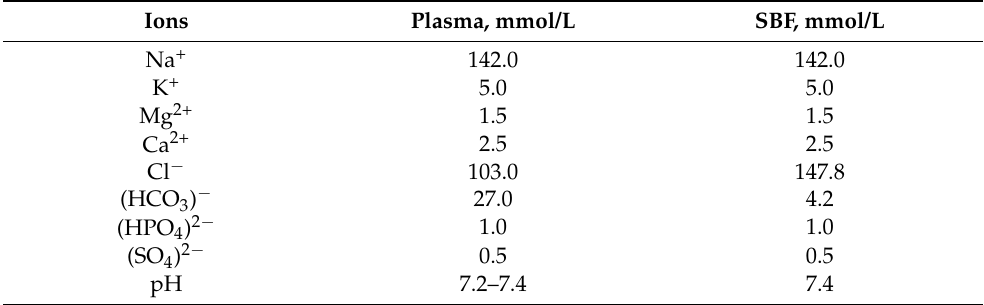
Table 1. The concentration of inorganic ions in simulated body fluid (SBF) and blood plasma. Ions Plasma,